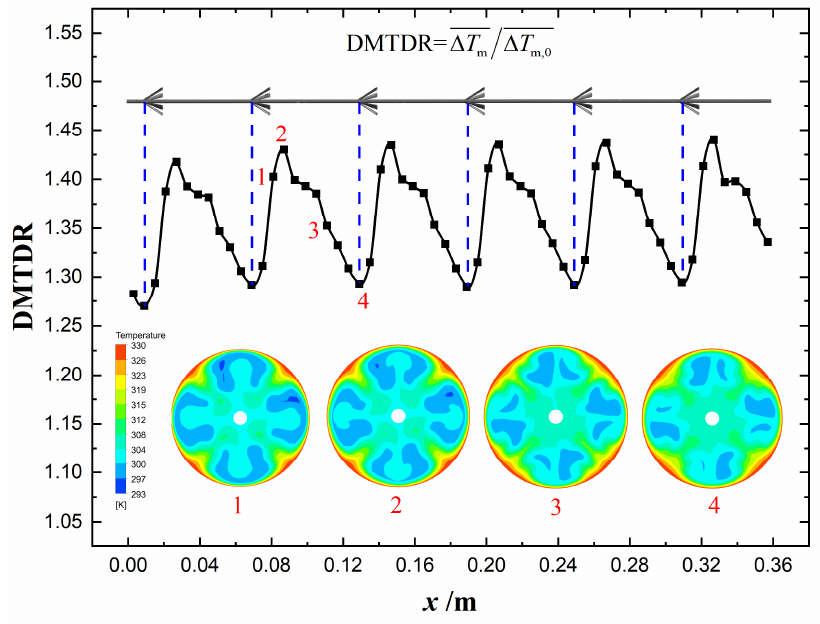
∆ T ∆ T T T Δ Δ along the tube at Re = 600. Figure 15. The variation of m / m,0 along the tube at Re m m,0